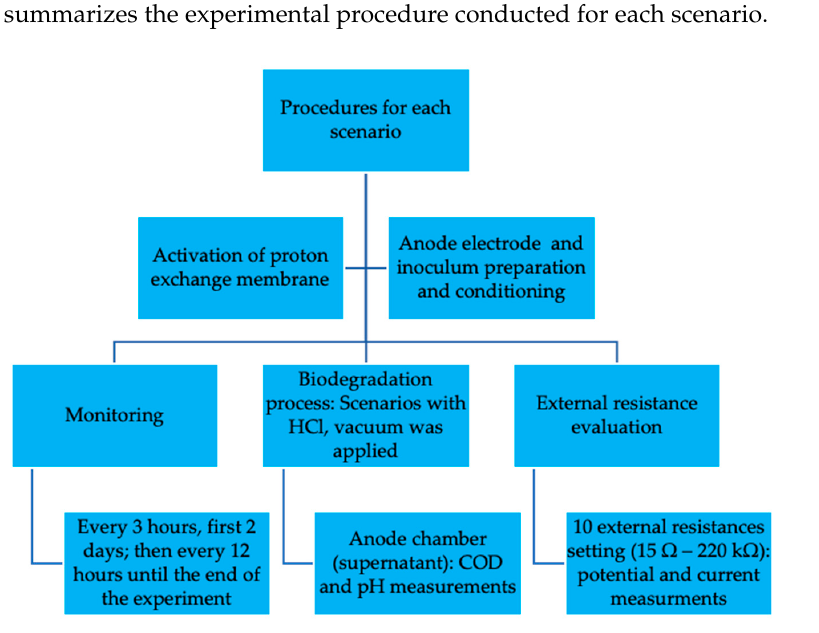
Figure 2. Experimental procedure conducted for each scenario.